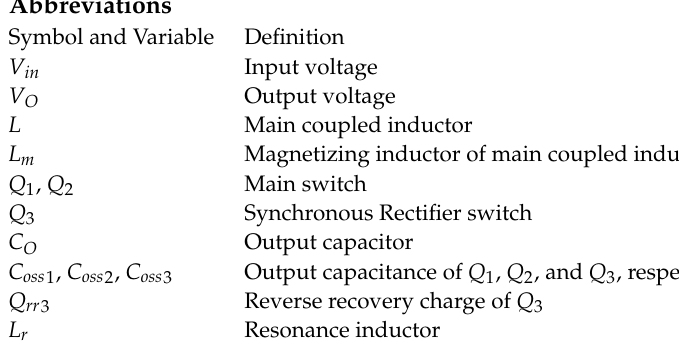
Figure 17. Photographs of the proposed prototype ( a ) view of top side; and ( b ) view of bottom side. Table 3. Measured results of phase margin and gain margin.